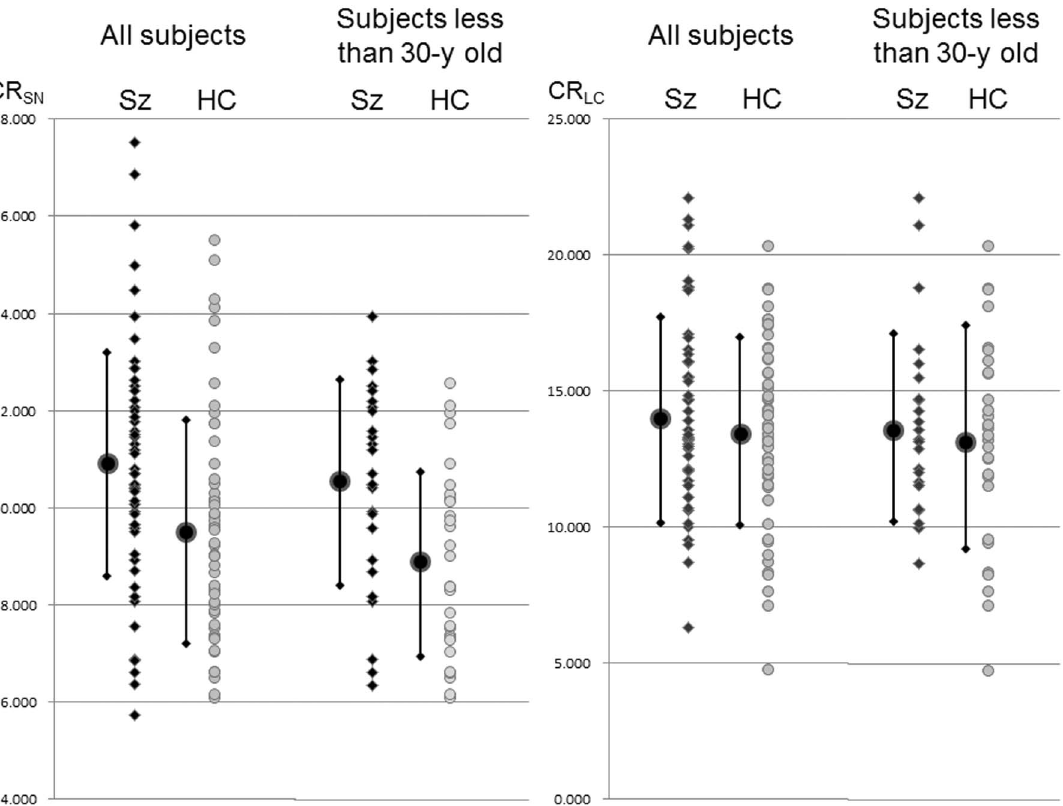
Figure 2. CR SN and CR LC for patients with schizophrenia and healthy controls. The left graph plots data for all subjects. The right graph plots data for selected patients under 30 years of age. The dots and bar show mean 6 standard deviation. The patients showed a significantly higher CR SN , but the variation in each group was large. The dispersion of data is small to select the young patients. There was no significant difference about CR LC between the patients and healthy controls. Figure 2). There was no significant difference for the subset of subjects over 30 years old.